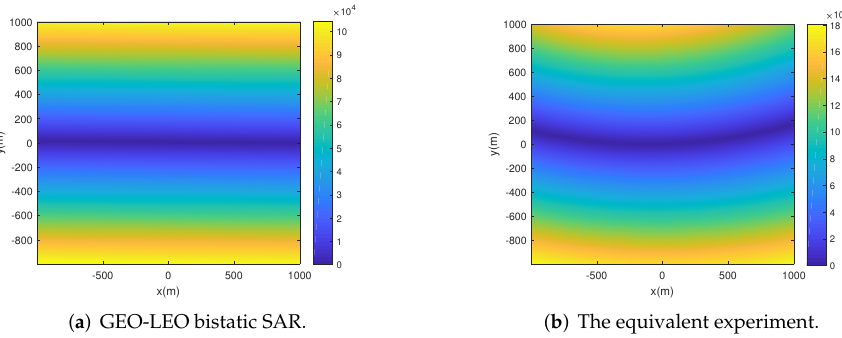
Figure 11. Spatial variance of GEO-LEO bistatic SAR and the equivalent experiment.